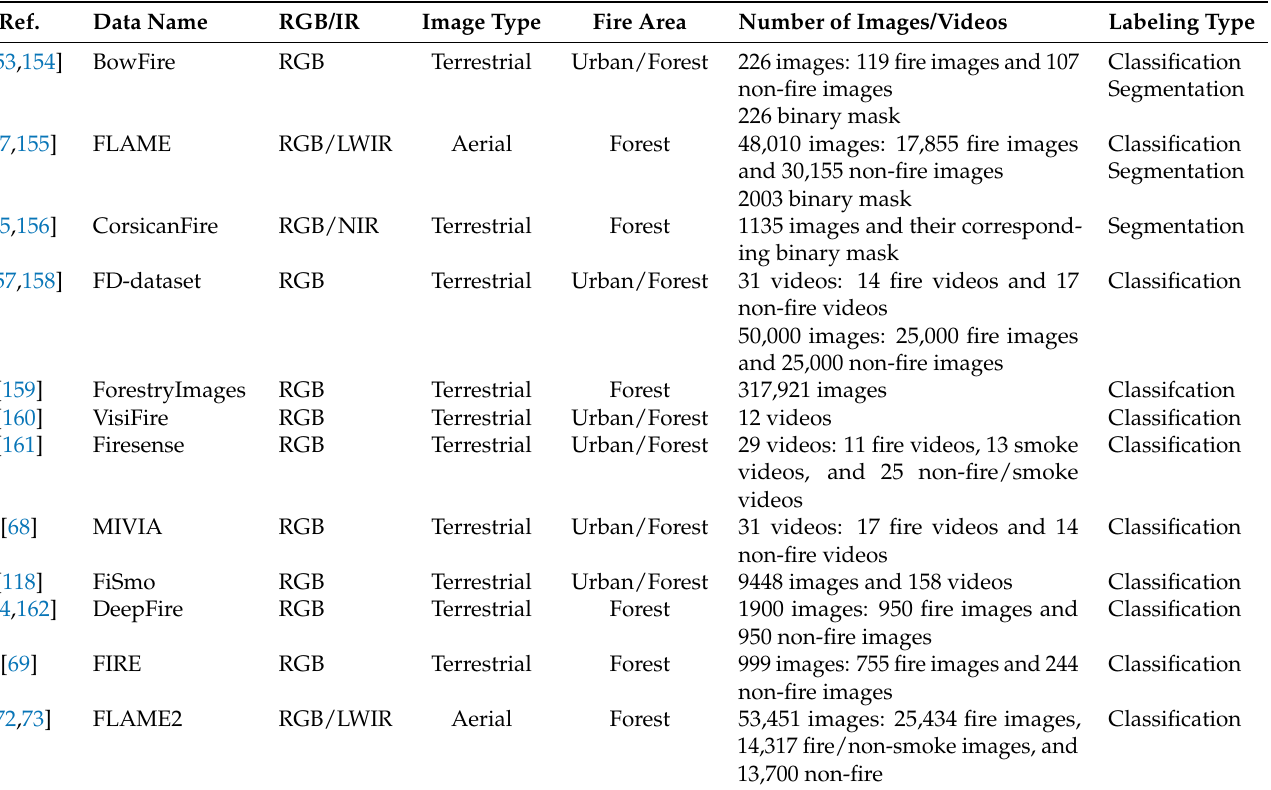
Table 4. Wildland fire datasets overview. RGB (visible spectrum) covers a wavelength range of 0.4 to 0.75 µm. NIR (Near Infrared) ranges from 0.7 to 1.4 µm. LWIR (Long Wave Infrared)) includes a wavelength range of 8 to 15